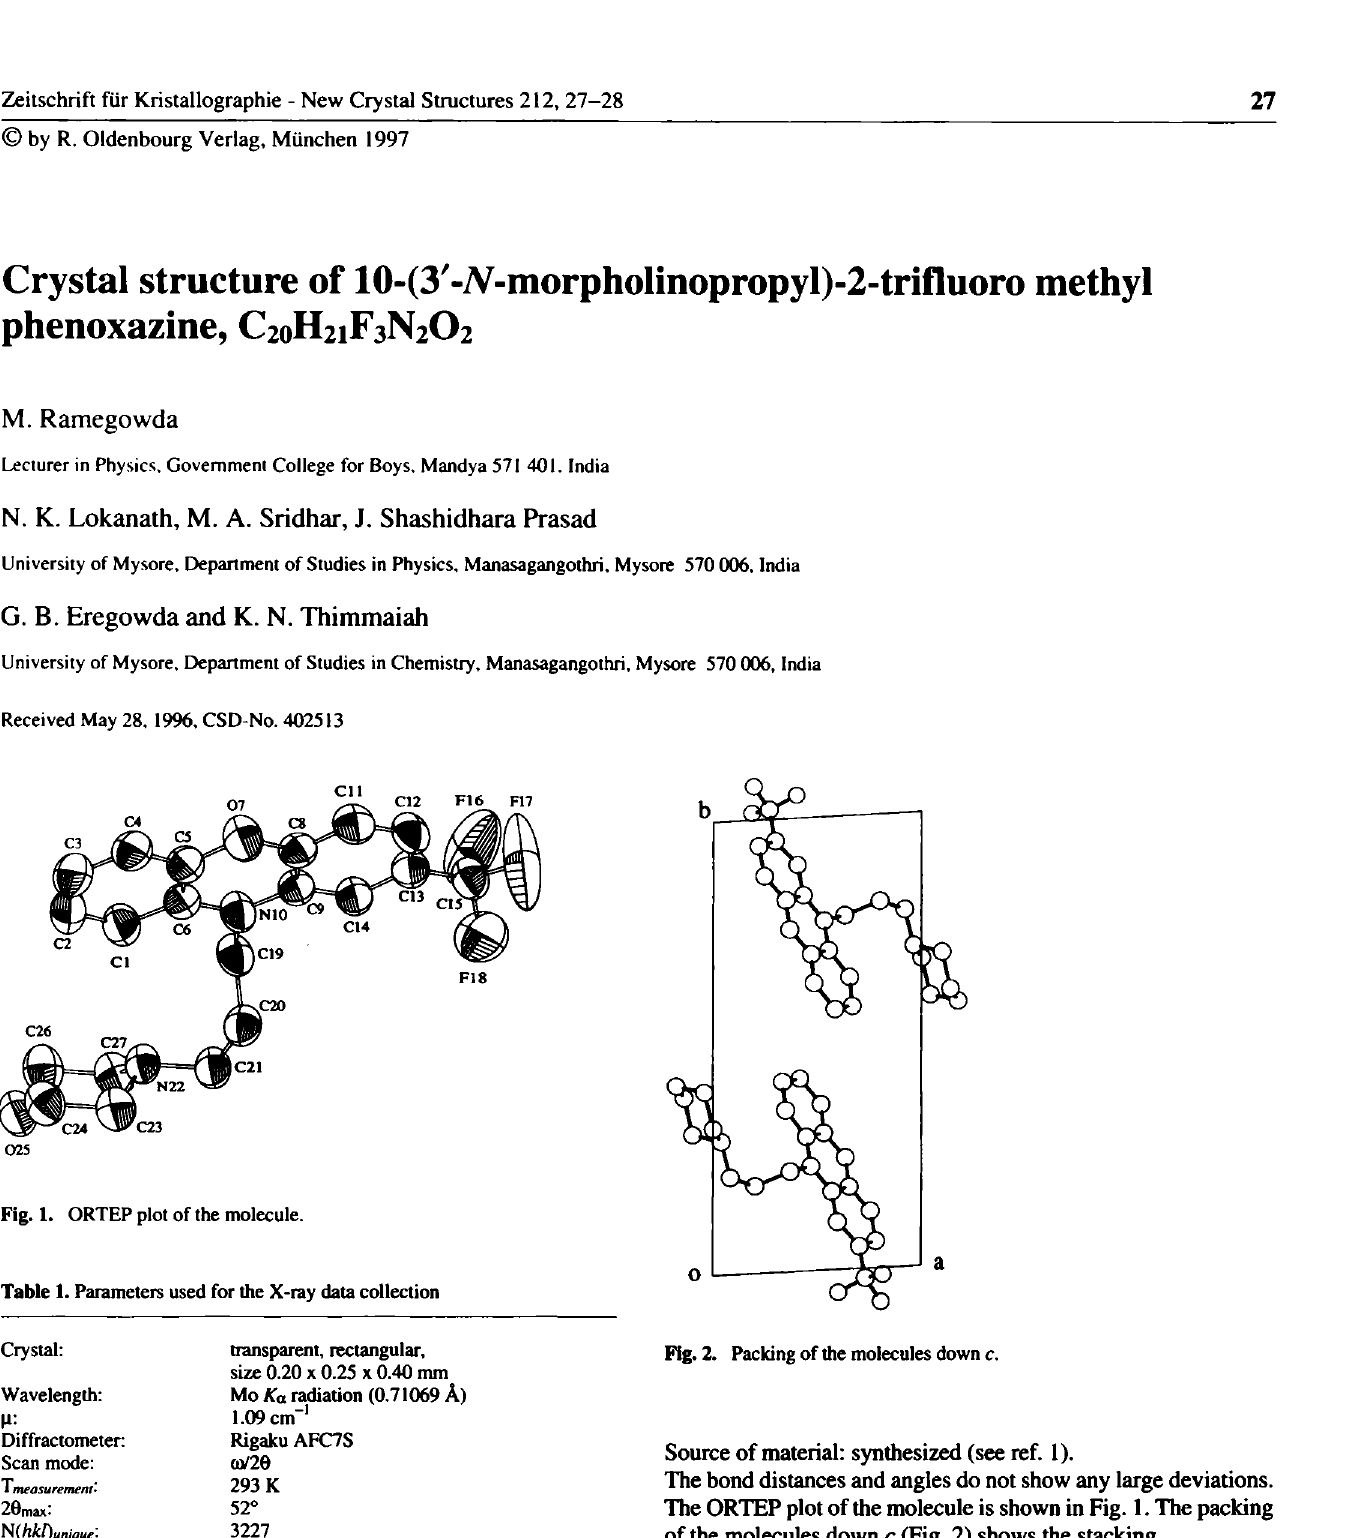
Source of material: synthesized (see réf. 1). The bond distances and angles do not show any large deviations. The ORTEP plot of the molecule is shown in Fig. 1. The packing of the molecules down c (Fig. 2) shows the stacking. C20H21F3N2O2, triclinic, P\ (No. 2), a =8.1964(8) Ä, b =18.051(1) Â, c =6.2477(8) Â, α =90.278(8)°, β